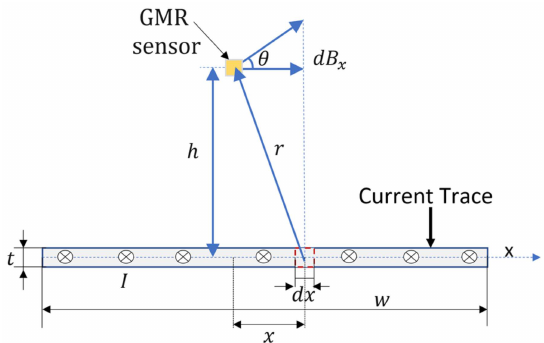
Figure 2. Cross section representing the parameters of the analytical model implemented for field